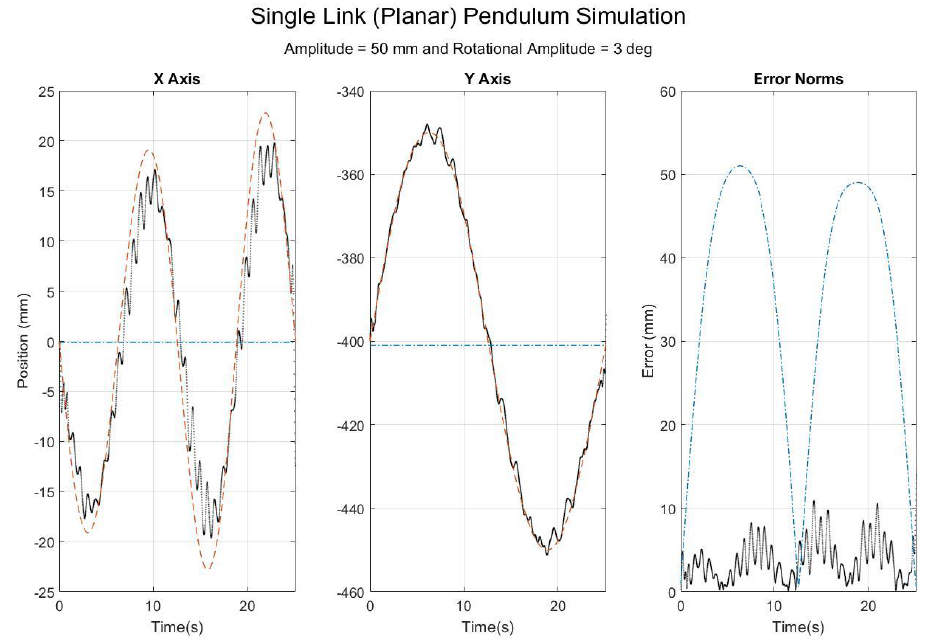
Figure 1. Results for planar, single-link simulation with translational and rotational soft tissue artifact (STA) added. The plotted data are expressed within the local frame of the inertial sensor. The red dashes refer to the theory solution, the black dots to the time-varying single-frame optimization (SFO) solution (as applied to the simulated inertial data), and the blue dash-dots to a static joint center solution [16].